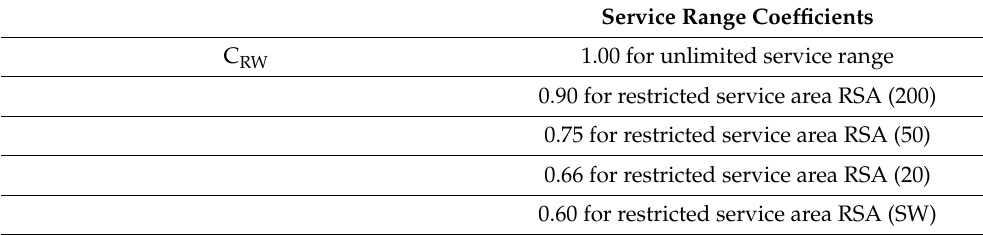
Table 6. Service coefficients.